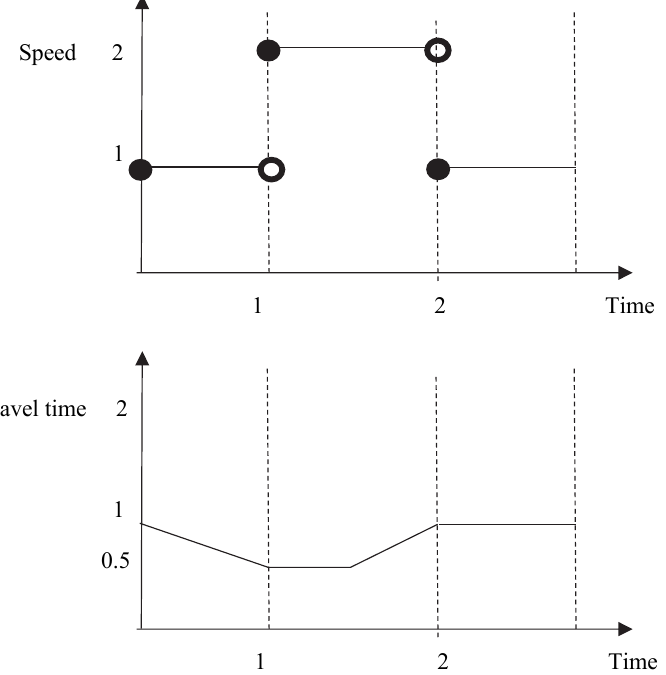
Fig. 2. The curve of speed-time and travel